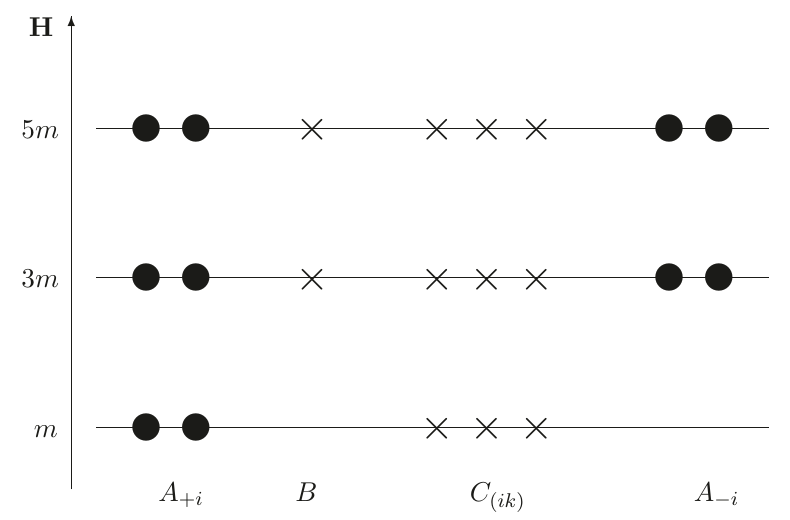
Figure 1 . The degeneracy of energy levels for q = 1 / 2. Circles and crosses indicate bosonic and fermionic states,